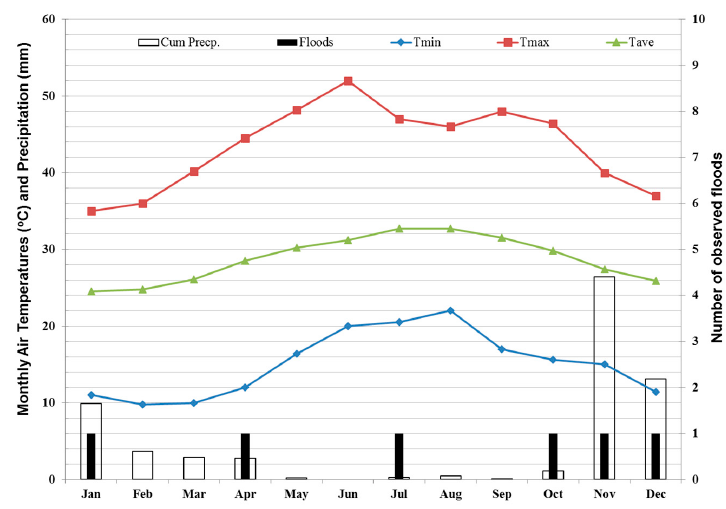
Figure 2. Monthly maximum, average and minimum air temperatures (°C), monthly cumulative precipitation (mm) and number of observed floods for Jeddah (Data source: https://en.wikipedia.org/wiki/Jeddah#Climate).